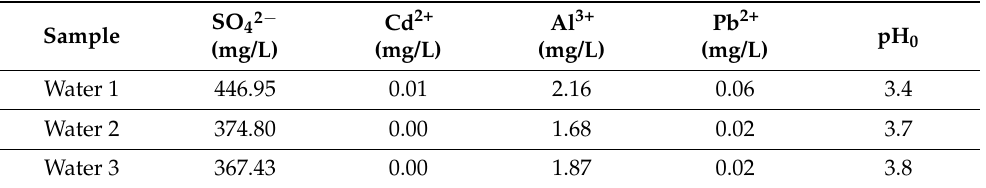
Table 8. Amount of sulfate and heavy metal ions in the real water sample and values for pH, conductivity, and solid